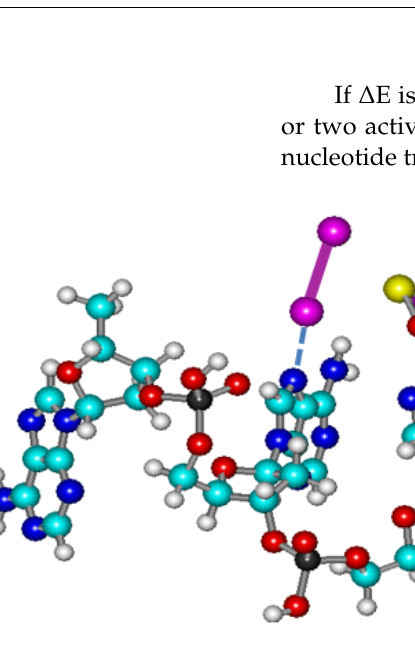
Figure 6. Complexes of active centers the FS-1 drug (LiI 3 complex IV, MgI 3 LiI 3 complex V) with nucleotide triplet AAG. Blue balls are carbon atoms, red—oxygen, dark blue—nitrogen, violet—iodine, green ball—magnesium ion, yellow—lithium ion, black—phosphorus, and white balls—hydrogen atoms. Table 4. Interaction energies (kcal/mol) of nucleotide triplets with active centers of the FS-1